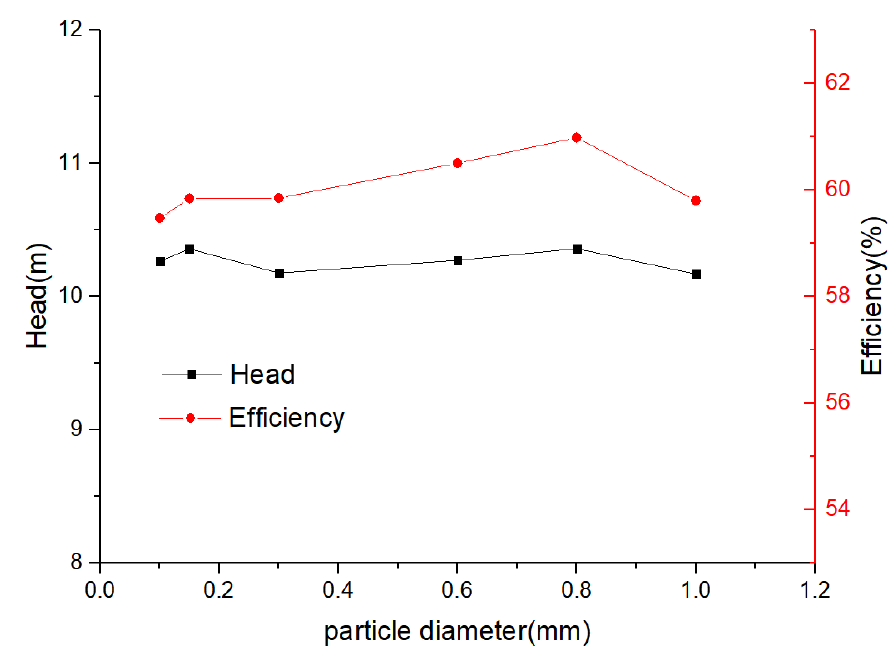
Figure 16. Pump performance characteristics curve at different particle diameters (1.0 Q BEP , C V = 5%).